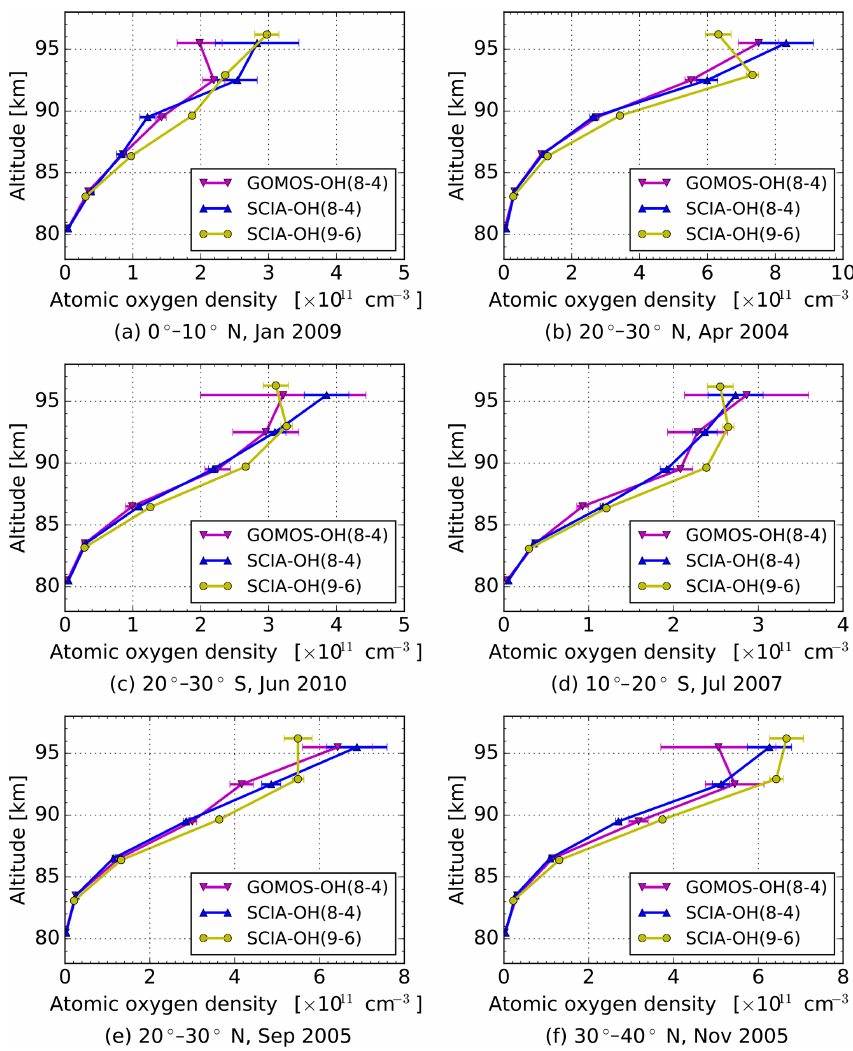
Figure 15. Comparison of monthly zonal mean atomic oxygen densities derived from hydroxyl airglow emissions observed by the GOMOS and SCIAMACHY instruments in various latitude bins for different months. SCIA-OH(9–6) represents the atomic oxygen dataset derived from the SCIAMACHY OH(9–6) band by Zhu and Kaufmann (2018); SCIA-OH(8–4) is the dataset from the SCIAMACHY OH(8–4) band; and GOMOS-OH(8–4) is from the GOMOS measurements of the OH(8–4)